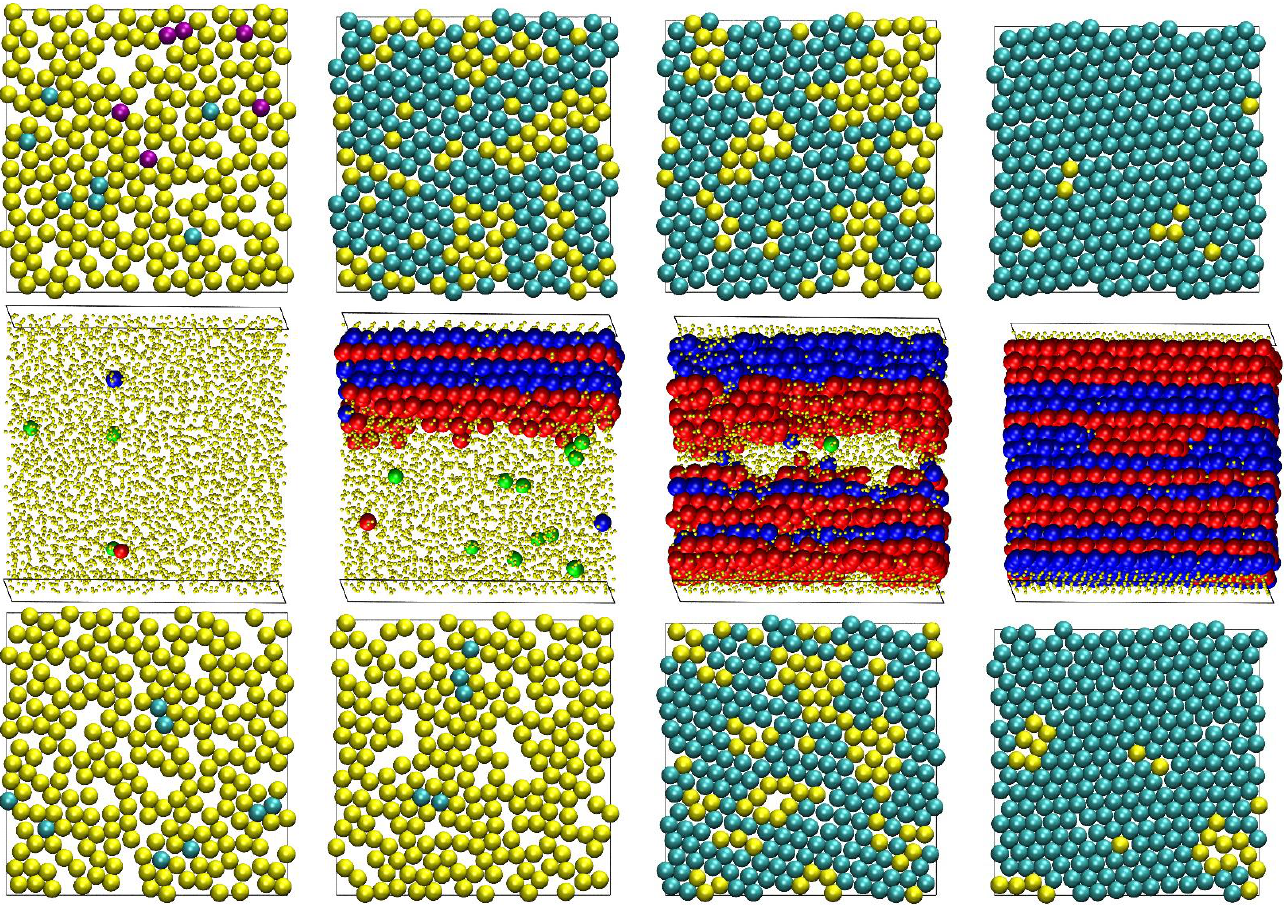
Figure 11. Snapshots of the system configurations for the N = 100 at ϕ = (from left to right ) 0.50, 0.54, 0.56, and 0.60 at the end of the MC simulation. The ( top ), ( middle ), and ( bottom ) panels correspond to the top layer, bulk volume, and bottom layer of the confined simulation cell. The atoms are colored-coded according to the crystal similarity, as identified by the CCE-norm analysis. For bulk crystallization (3-D CCE), blue, red, and green correspond to the HCP-, FCC-, and FIV-like sites, respectively. For surface crystallization (2-D CCE), cyan, purple, orange, and green correspond to the TRI-, SQU-, HON-, and PEN-like sites, respectively. The amorphous (AMO) sites are colored in yellow. In 3-D, the AMO sites are further shown with reduced dimensions (in a 1:5 ratio) for visual clarity. The figure panels are also available as 3-D, interactive images.